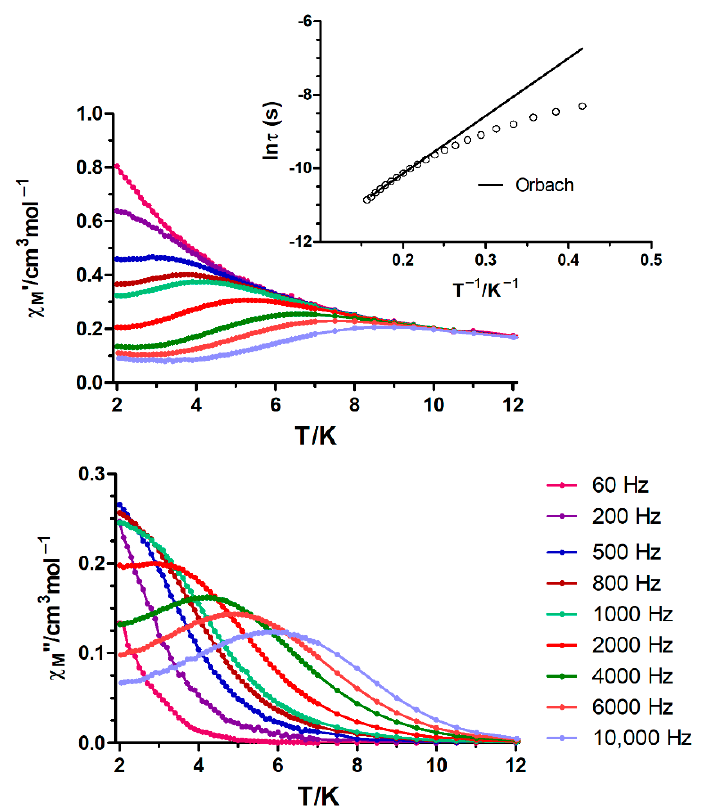
Figure 6. Temperature dependence of in-phase χ M ’ and out-of phase χ M ” components of the alternating current ac susceptibility for complex 15 under an applied field of 1000 Oe. Inset: Arrhenius plot for the temperature dependence of the relaxation times of 15 (black line).